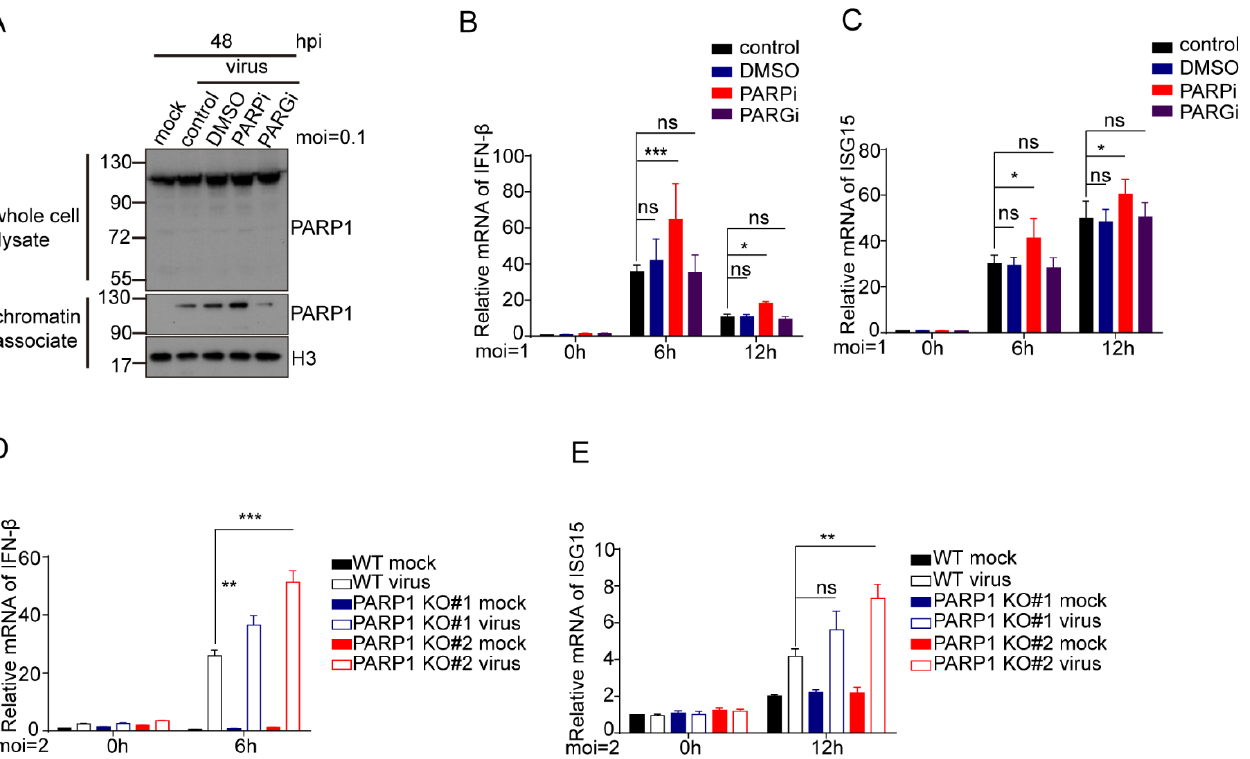
Figure 8. PARP-1 inhibition or depletion attenuates HCMV replication by promoting HCMV triggered induction of type Ⅰ IFNs. ( A ) PARP-1 inhibition increased HCMV infection-induced PARP-1 trapping on genomic DNA, while PARG inhibition decreased this trapping effect. MRC-5 cells were infected with HCMV at an MOI of 1. After adsorption, culture medium was replaced with fresh medium containing DMSO, 10 µM Olaparib, or 10 µM PARG inhibitor, respectively. Drugs were replenished every 24 h. At 48 hpi, the cells were collected and cell fractions were analyzed by Western blot with indicated antibodies. ( B , C ) PARP inhibition increased the transcription of IFN- β ( B ) and ISG15 ( C ) in HCMV-infected MRC-5 cells at indicated times. MRC-5 cells were infected with HCMV at an MOI of 1 and treated as panel A. RNA was extracted and reverse transcribed to cDNA. Expression profiles of IFN- β and ISG15 were analyzed by RT-qPCR. Data were analyzed by one-way ANOVA. * p < 0.05, ** p < 0.01, *** p < 0.001. ( D , E ) PARP-1 depletion upregulates the transcription of IFN- β ( D ) and ISG15 ( E ) in HCMV-infected immortalized HFFs at indicated times. Wild type or PARP-1 depleted immortalized HFFs were infected with HCMV at an MOI of 2, and total RNA were extracted at indicated times. After being reverse transcribed to cDNA, the expression profiles of IFN- β and ISG15 were analyzed by RT-qPCR. Data were analyzed by one-way ANOVA. * p < 0.05, ** p < 0.01, *** p < 0.001.